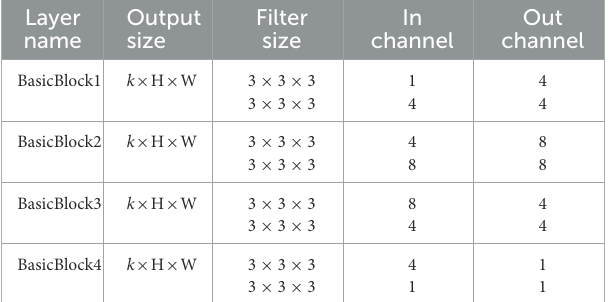
TABLE 1 The filter size and the input/output shape in the BasicBlocks. Layer